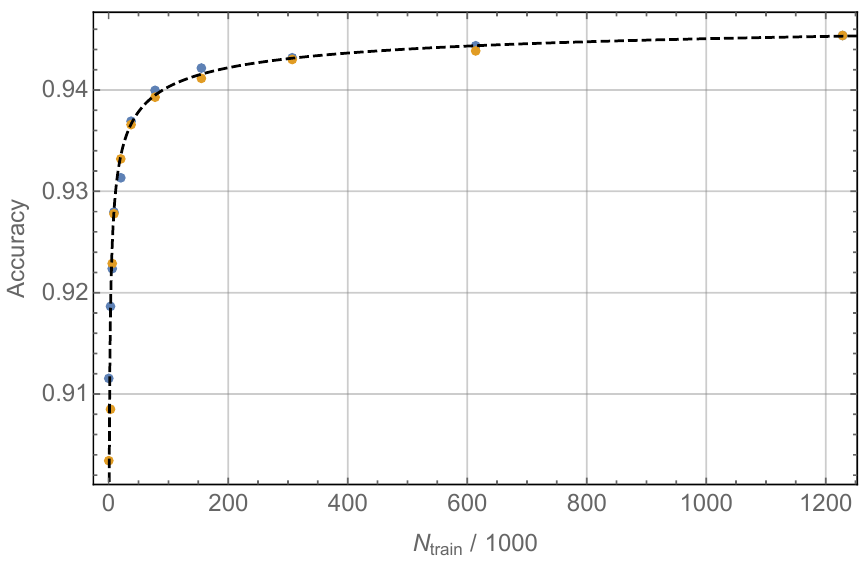
Figure 3 . In blue (yellow) are the learning curves for the test accuracy vs. training sample size for the CMS jets (DeepTop jets). The CNN used is our (cid:12)nal tagger but with grayscale images. The learning curve for DeepTop jets has been shifted up by a constant o(cid:11)set of 0.075. Shown also in black, dashed is a heuristic least-squares (cid:12)t to an inverse power law with uncertainties given by 1 =